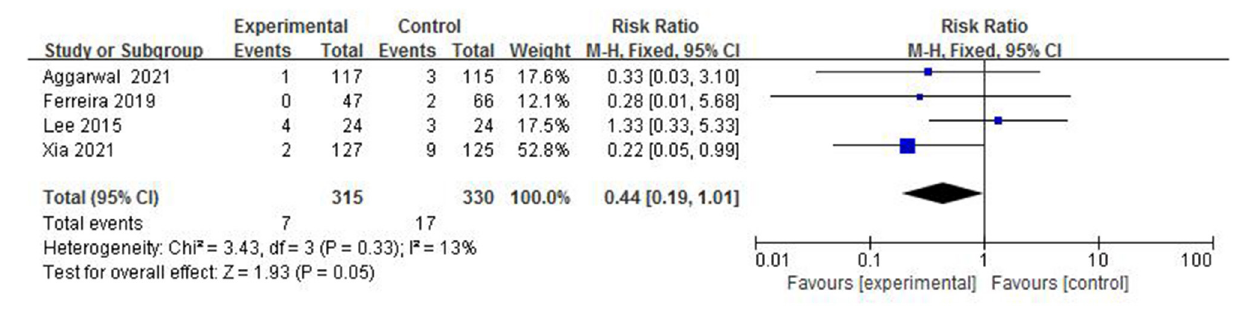
FIGURE 11 | Forest plot of the incidence of IVH (grade ≥ 3).